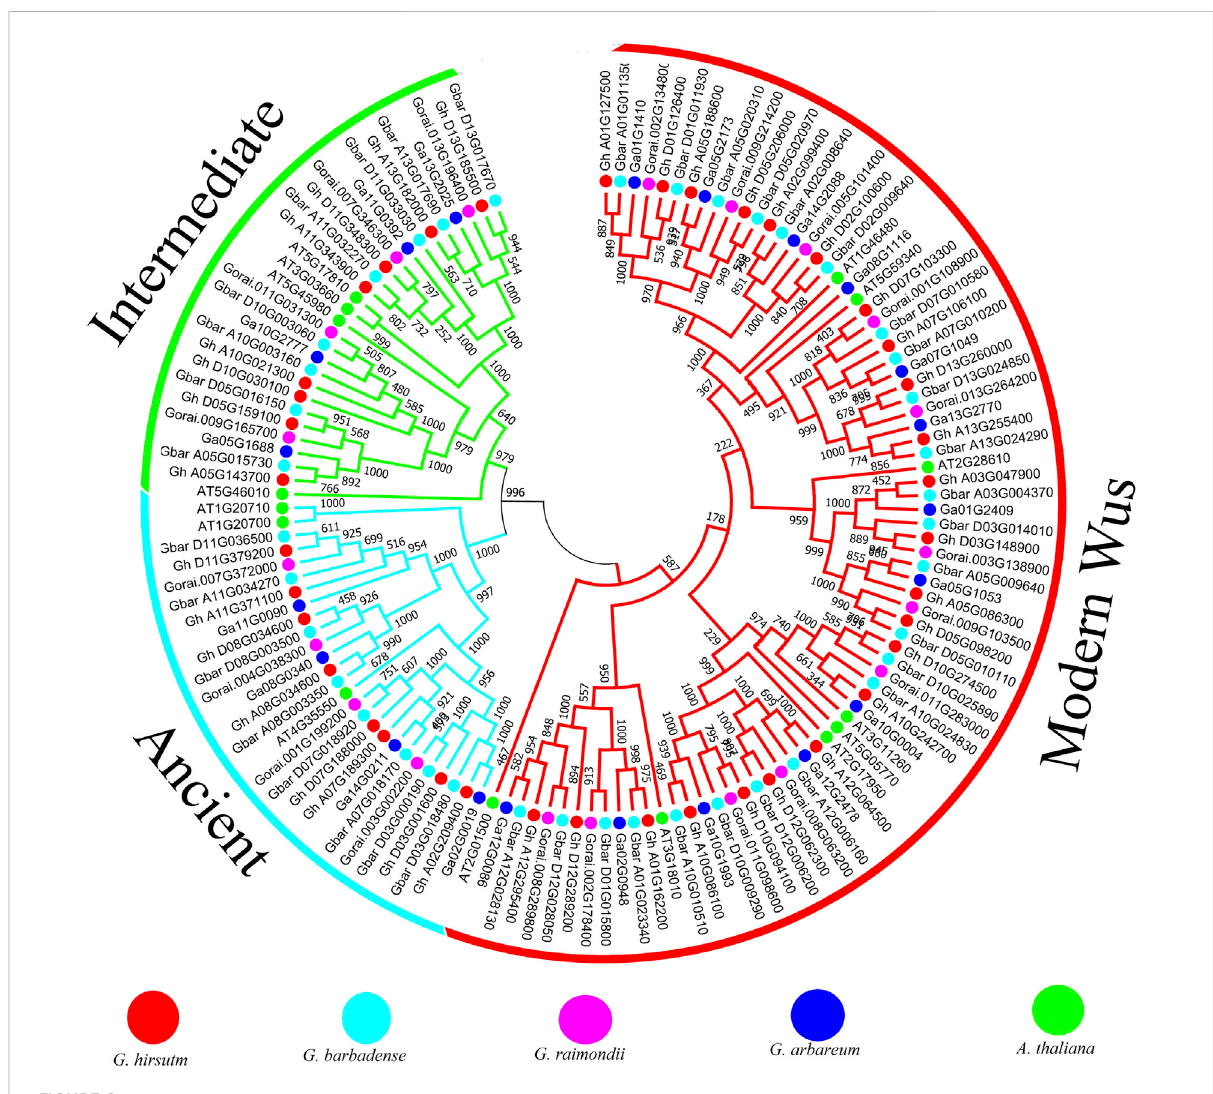
FIGURE 2 Phylogenetic tree of WOX genes in Gossypium species and Arabidopsis